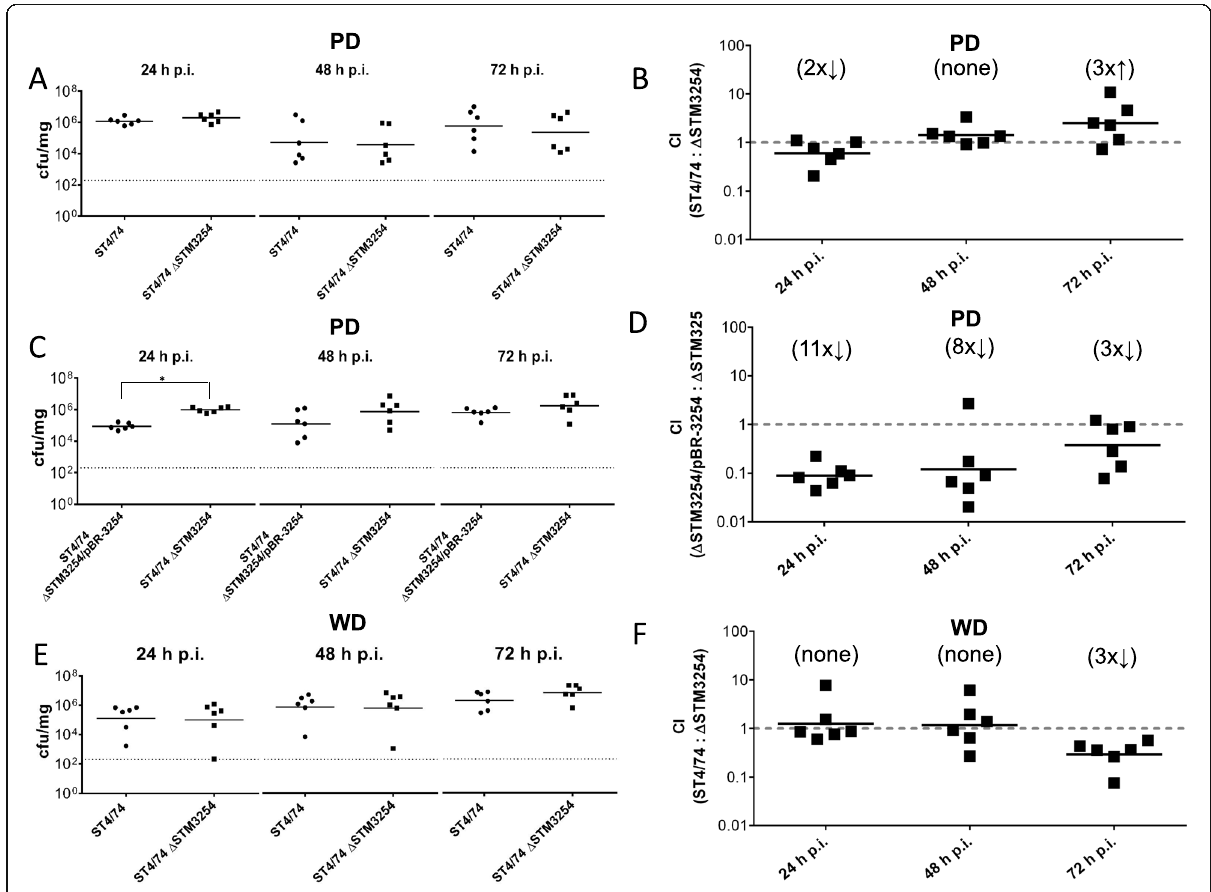
Fig. 6 Deletion of STM3254 leads to reduced infection numbers in C57/BL6J mice over time. Two groups of female C57/BL6J mice (n = 6 each group) were fed the PD or the WD and orally infected with a 1:1 ratio of ST4/74 and ST4/74 Δ STM3254::Kan R , and on group ( n = 6) was fed the PD and infected with a 1:1 ration of ST4/74 Δ STM3254::Kan R and ST4/74 Δ STM3254::Kan R /pBR-3254. The total inoculum was 5 × 10 7 CFU/mouse. Stool samples were taken every 24 h up to 3 days ( a , c , e ). The CFU per mg feces of each strain are shown over time. The numbers of ST4/74 (circles) ST4/74 Δ STM3254::Kan R (squares) (or ST4/74 Δ STM3254::Kan R (circles) and ST4/74 Δ STM3254::Kan R /pBR-3254 (squares) recovered in each mouse after co-infection are depicted. Solid horizontal lines indicate mean values while dashed lines lines represent the detection limit for each sample. b , d , f ) CIs depict the ratio of ST4/74 and ST4/74 Δ STM3254::Kan R , or ST4/74 Δ STM3254::Kan R and ST4/74 Δ STM3254::Kan R /pBR-3254). The geometric mean for each group was compared to the theoretical value of 1.0 and the fold-change difference is indicated in parentheses. Significant differences ( p value ≤ 0.05) are indicated by